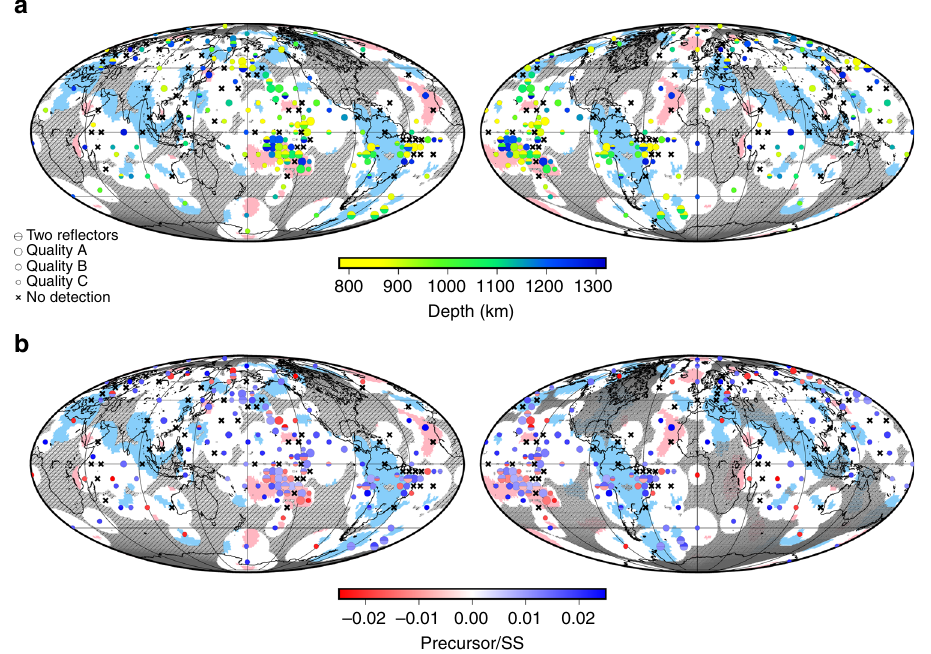
Fig. 3 Depths and impedance contrasts of observed mid-mantle re fl ectors. a Discontinuity depths, with observations (circles) and bins with non-detections (crosses). Symbols are plotted at the average geographic location of bounce points within each bin, and circle sizes are scaled by quality of observations. Bins without suf fi cient coverage are omitted (Supplementary Fig. 7). Superimposed are average tomographically fast (blue) and slow (pink) regions at 1100 km depth 40 . Hatched regions are those with no data coverage from the bins shown. b Corresponding plot showing precursor/SS amplitude ratios. The maps are populated iteratively, beginning with the smallest bin sizes, to produce the highest possible data coverage (see Methods section). The data coverage (non-hatched areas; see also Fig. 5, Supplementary Figs. 4 and 5) provides an indicator as to the sensitivity of each